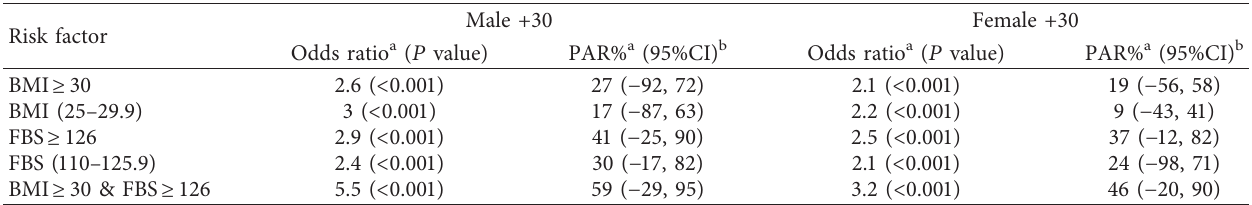
Table 2: Adjusted population attributable risk and 95% confidence interval of HBP due to overweight, obesity, impaired blood sugar, and HBG, and estimated odds ratios for HBP among over 30-year-old population by sex